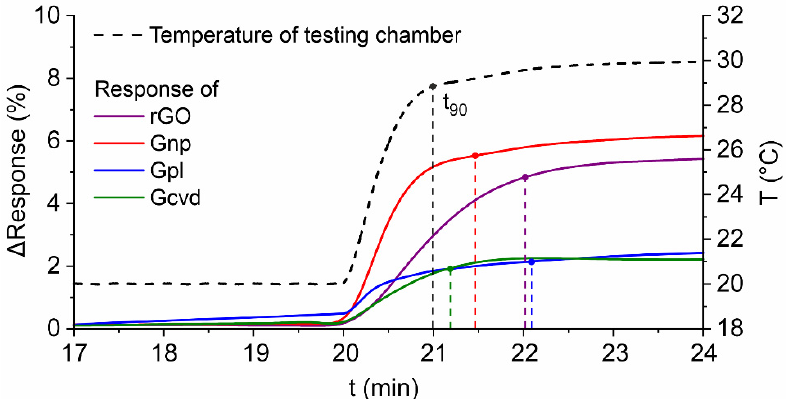
Figure 6. Sensors’ response time to temperature step change from 20 °C to 30 °C with the marked value t 90 for each sensor (and also temperature rise).